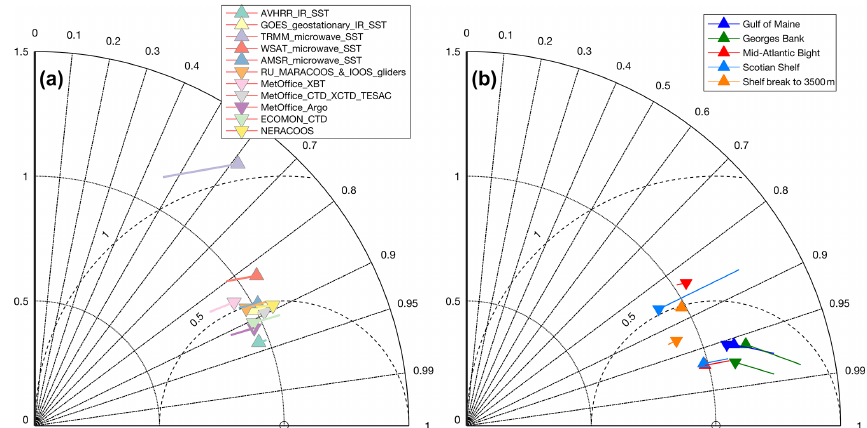
Figure 13. Taylor diagrams. (a) Doppio model skill against temperatures from satellite products including AVHRR, GOES, TRMM, WSAT, and AMSR and in situ observations throughout the water column, including gliders from MARACOOS and IOOS, UK Met Office XBTs, CTDs, Argo floats, ECOMON CTDs, and NERACOOS moorings. (b) Doppio model skill against the suite of observations represented in (a) but split into the five subregions (see Fig. 6) with (cid:49) for sea surface temperature and ∇ for subsurface temperature.